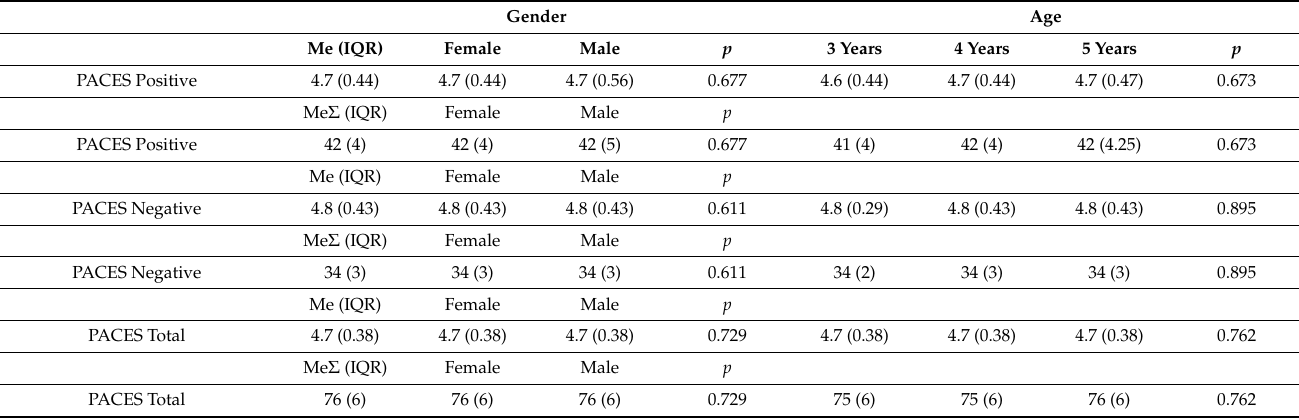
Table 4. Differences in dimensions by gender and